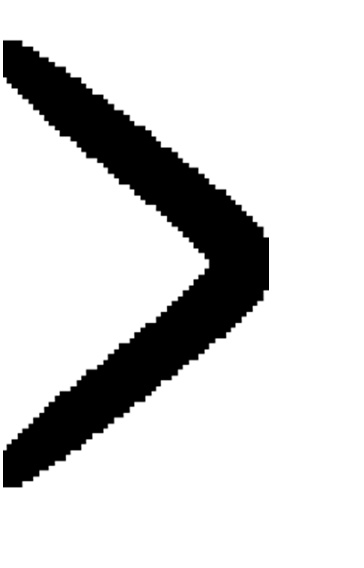
Figure 8. Short cantilever optimization results (the blue color shows the converged ρ e 1 = 1 , the red color shows the converged ρ e 2 = 1 , and the green color shows the misconverged or void areas). Table 2. Data of The Cantilever Optimization Results